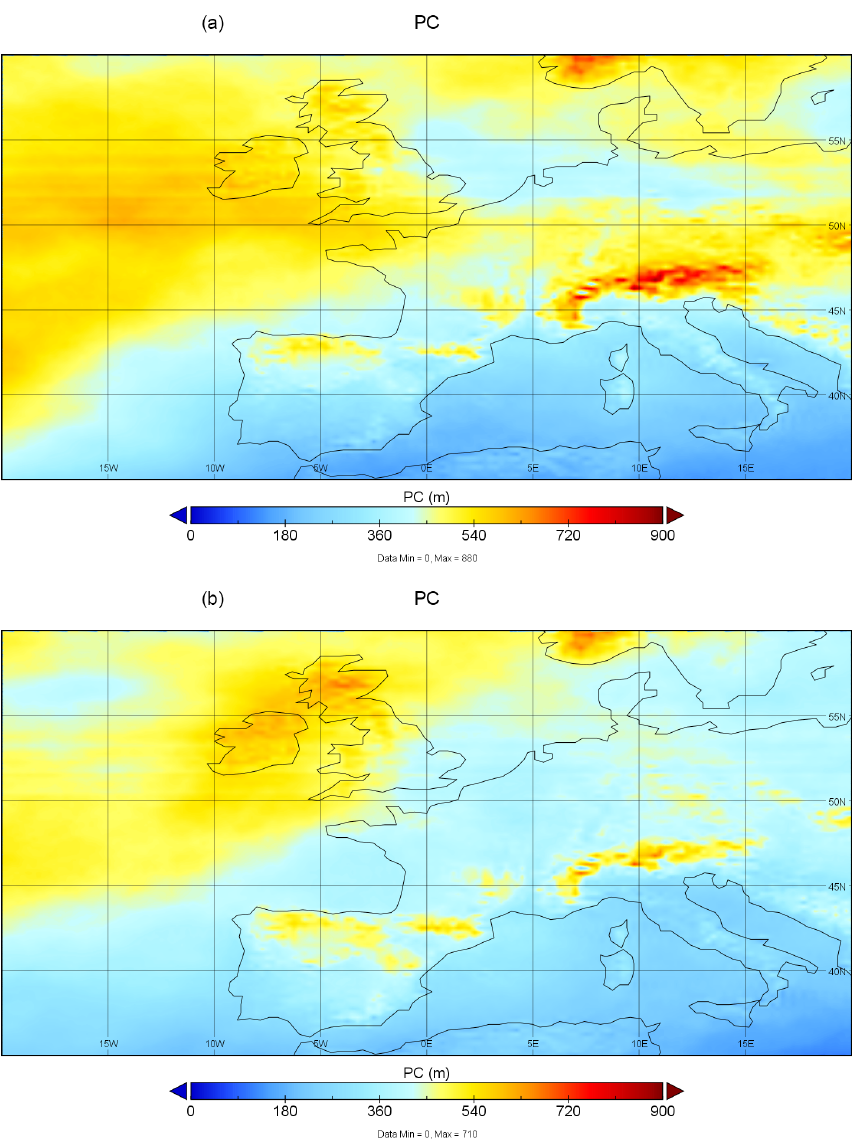
Figure 6. Mean vertical thickness (in m) of layers conditioned for the formation of persistent contrails in March–August 2019 (a) and 2020 (b)